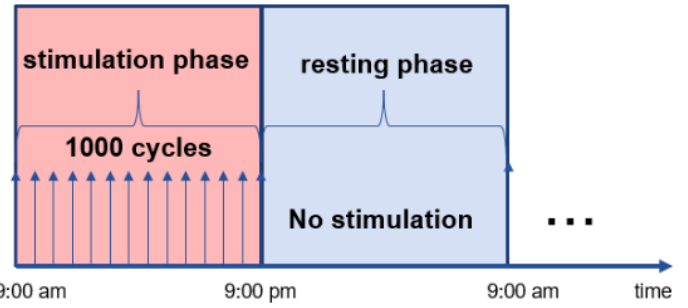
Figure 2. Pictorial representation of the stimulation protocol. Every day, 1000 stimulation cycles were equally distributed from 9:00 a.m. to 9:00 p.m. (stimulation phase) and no stimulation was applied overnight (resting phase). The stimulation protocol was applied from the first day post-op for the entire duration of the study. The arrows represent the applied stimulation and the dots ( . . . ) indicate that the same protocol was recuring every day.